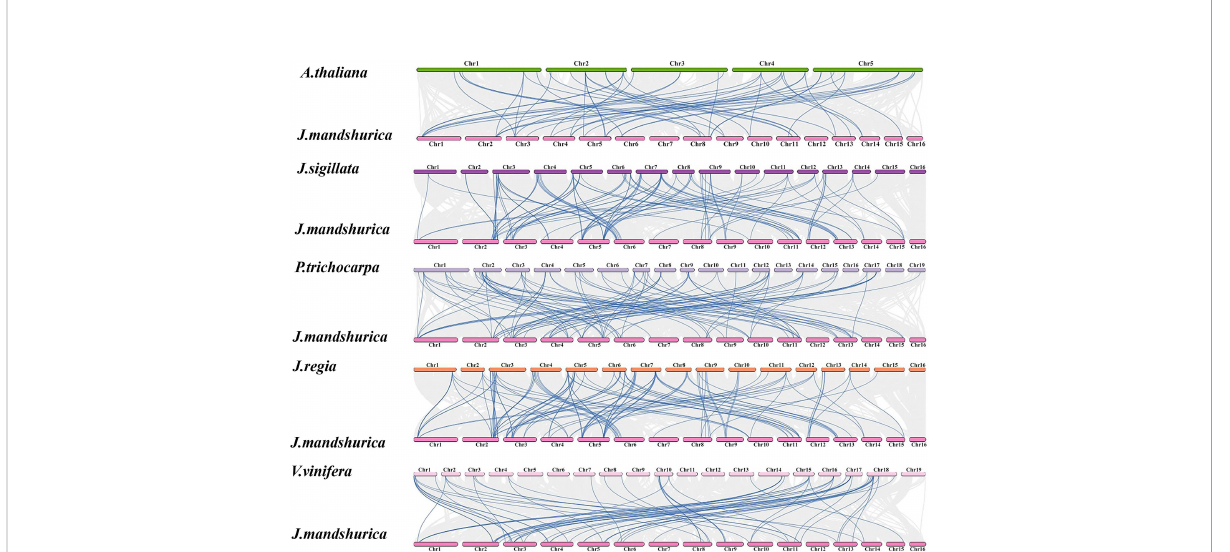
FIGURE 4 Synteny analysis of the MADS-box genes between J. mandshurica and A. thaliana , J. sigillata , P. trichocarpa , J. regia , and V. vinifera . The gray lines indicate gene blocks in poplar that are orthologous to other genomes. The blue lines delineate the syntenic MADS-box gene